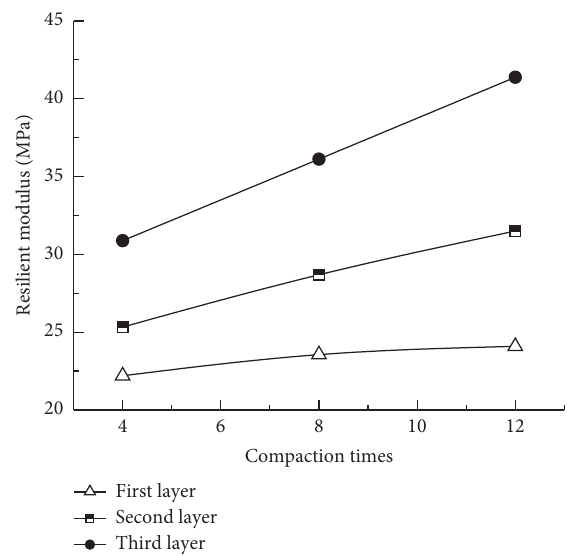
Figure 14: The resilient modulus changes with compaction times.